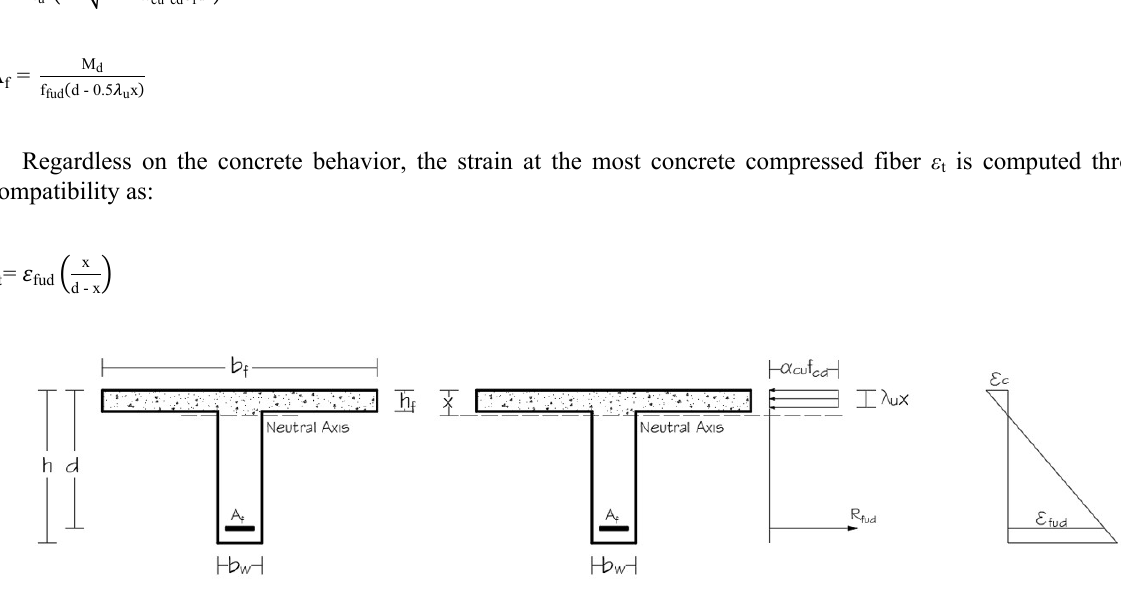
Figure 5. Equilibrium and compatibility conditions of a tension-controlled section for which concrete behaves non-linearly